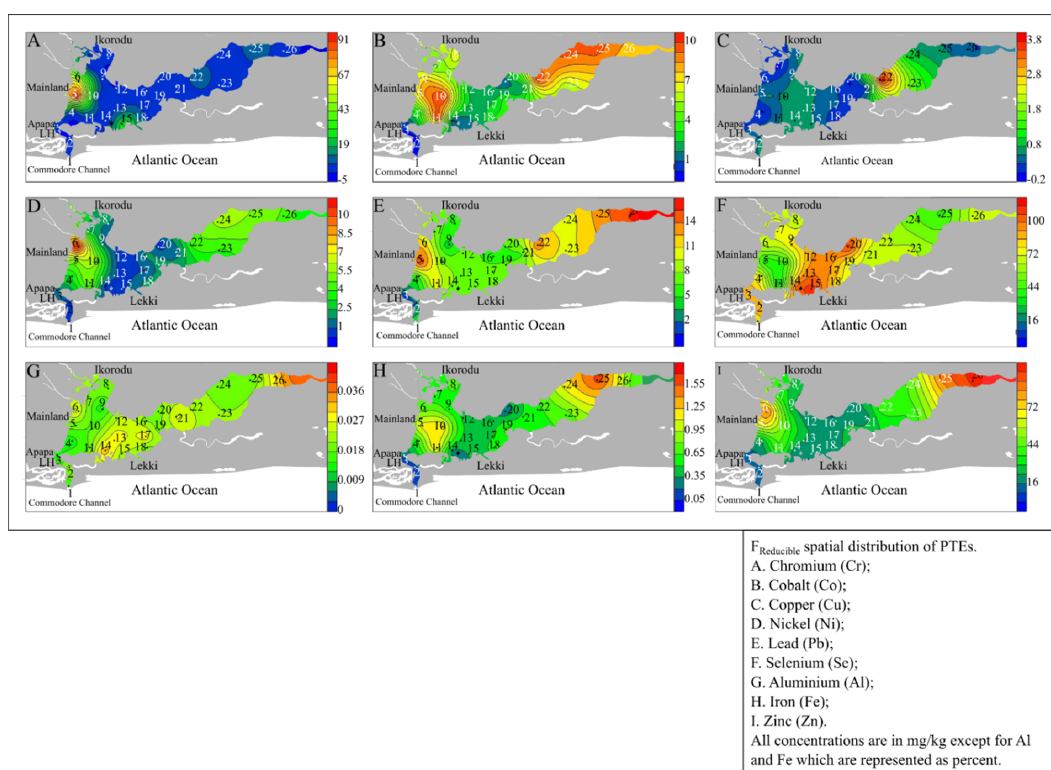
Figure A3. Reducible fractions heat maps.